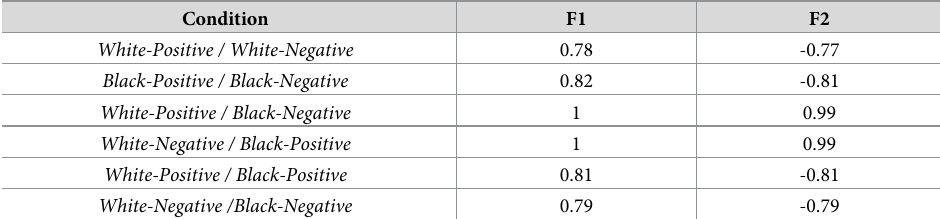
Table 5. Tucker’s Phi congruence value calculated for the two factors extracted on each couple of